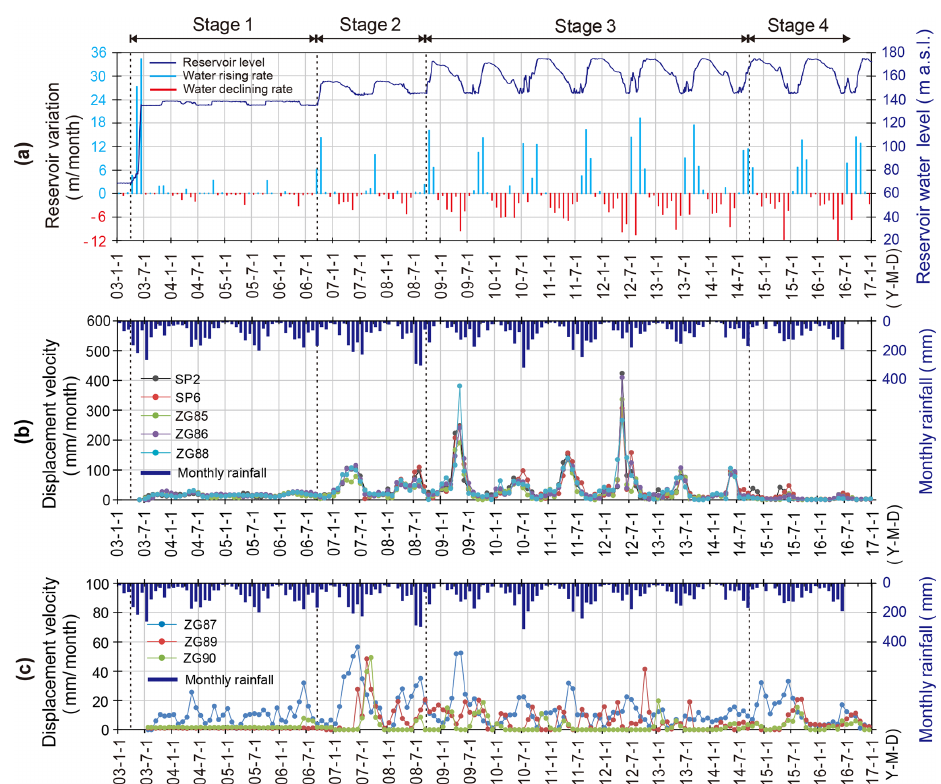
Figure 10. Time series of reservoir level, rainfall, and landslide displacement from 2003 to 2016. (a) Reservoir water levels and variation rates (positive for level rise, negative for level drop), (b) displacement velocity of the GPS points in the main deformation area and monthly rainfall, (c) displacement velocity of the GPS points in the secondary-deformation area and monthly